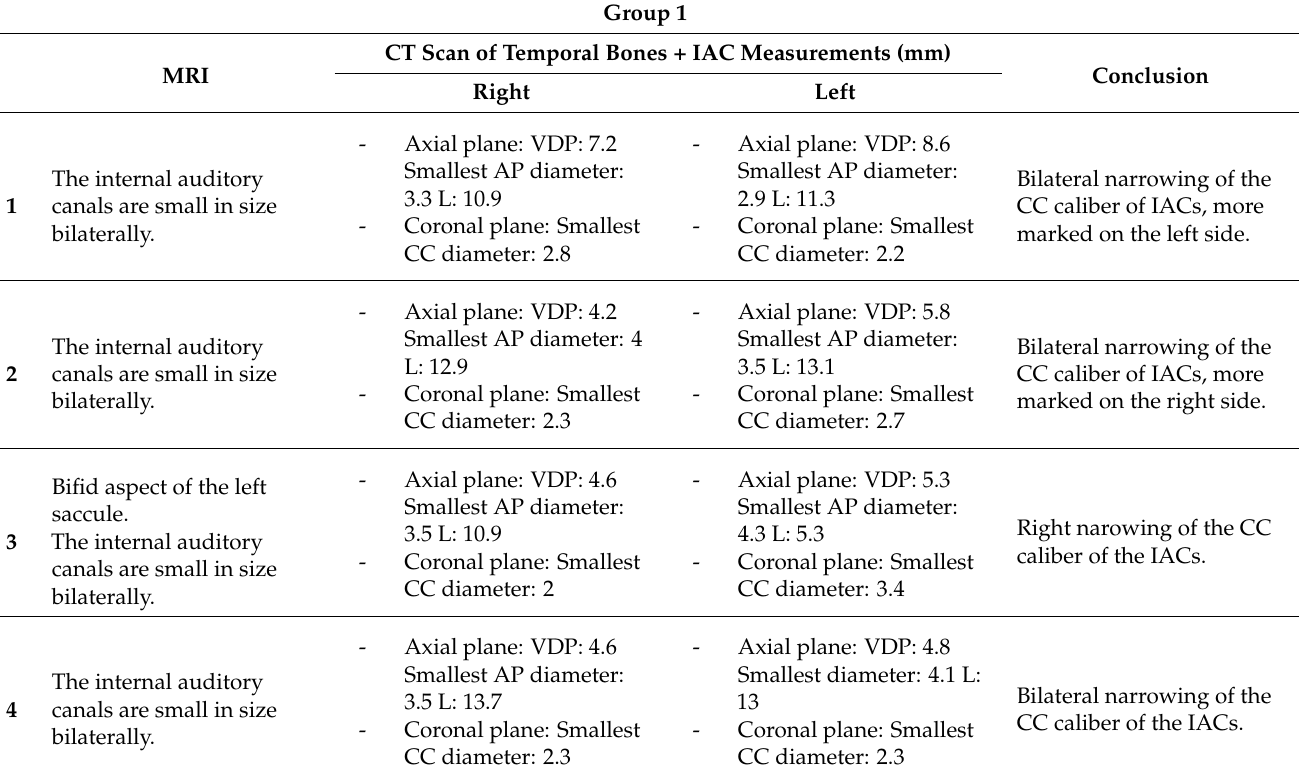
Table 3. Radiologic data and IAC measurements (in mm). AP (anteroposterior), L (length), CC